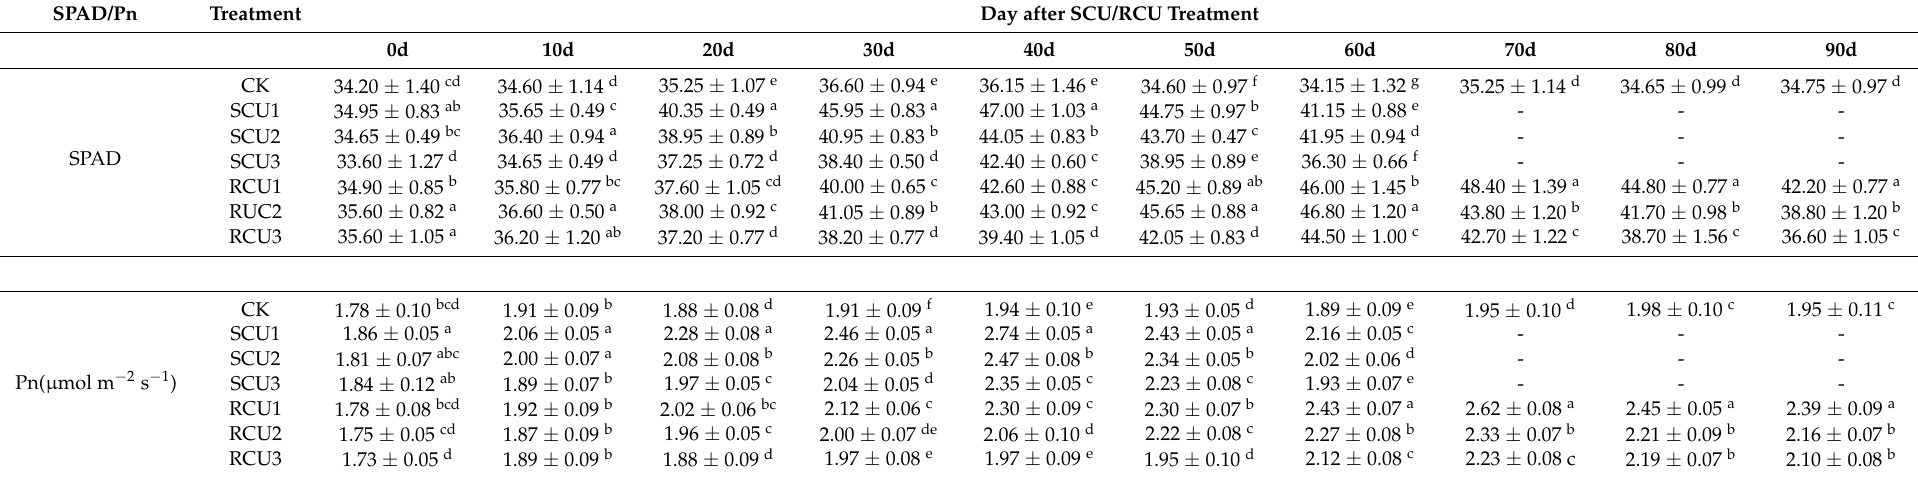
Table 1. The SPAD value and Pn under SCU and RCU treatment.